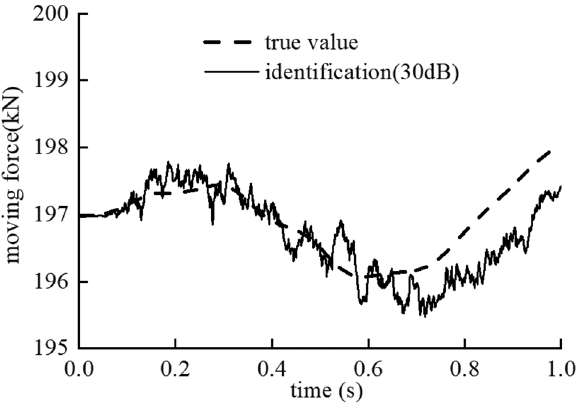
Figure 8. Identification result of moving force in the last iterative process.